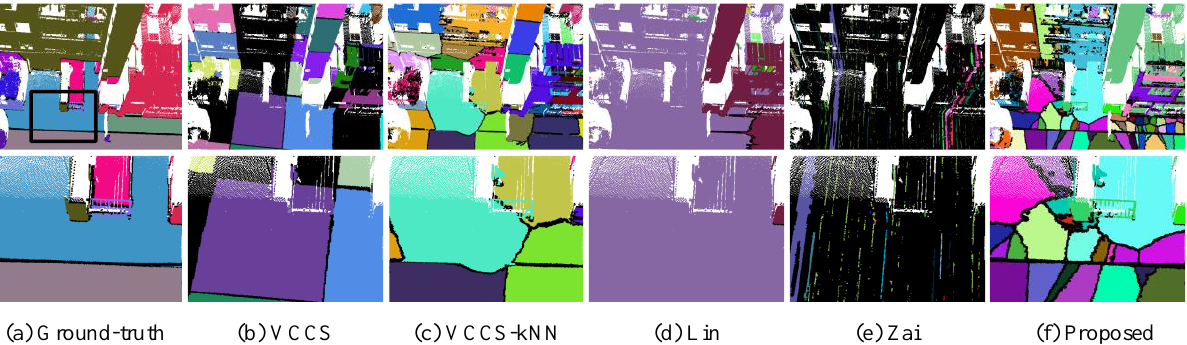
Figure 4. Visual representation of supervoxel results on IQTM dataset.